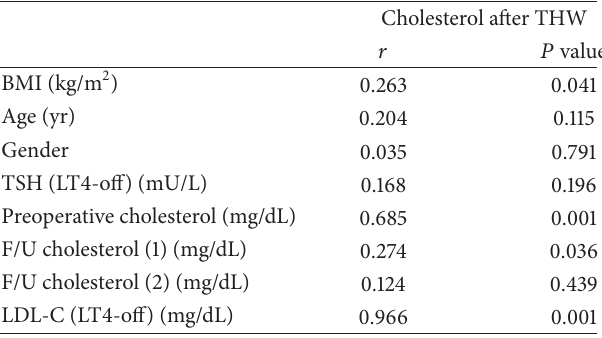
Table3:Correlationbetweenvariousclinicalparametersandserum cholesterol level after thyroid hormone